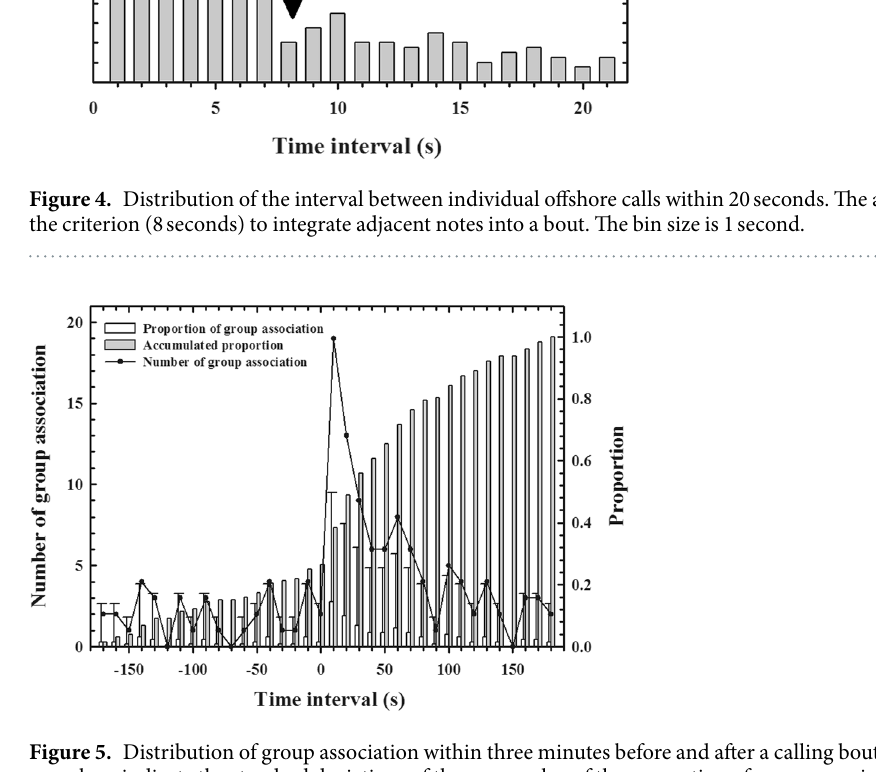
Figure 5. Distribution of group association within three minutes before and after a calling bout (n = 132). The error bars indicate the standard deviations of the mean value of the proportion of group